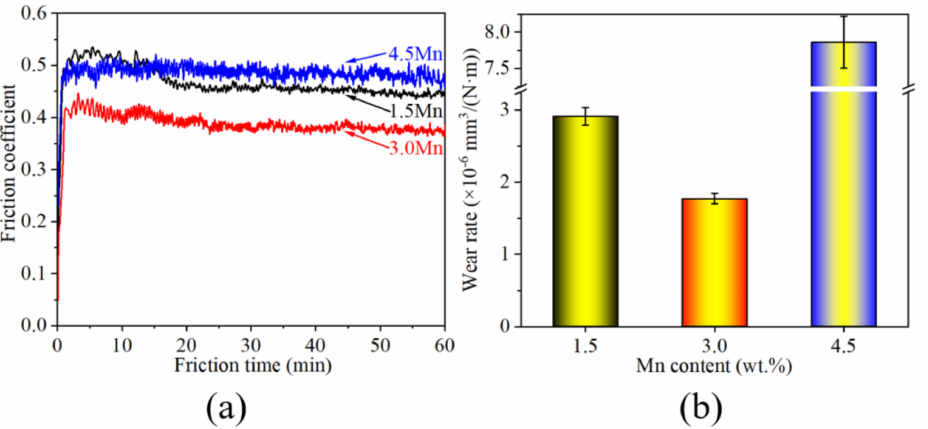
Figure 9. Friction coefficient ( a ) and wear rate ( b ) of three